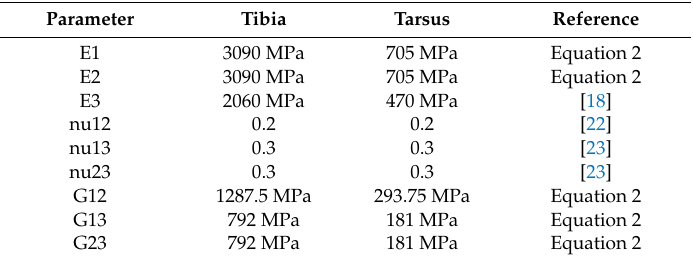
Table 1. Used material parameters for modeling the transversal isotropic material properties